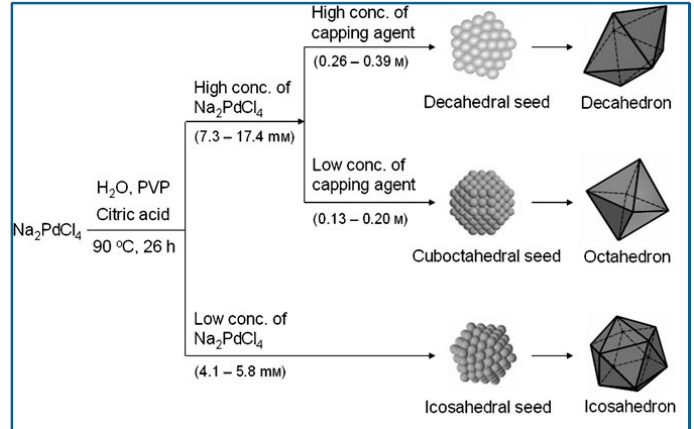
Figure 6. Reaction pathways leading to structure controlled Pd nanocrystals. Reproduced with permission [74]. Copyright 2007, Wiley-VCH.